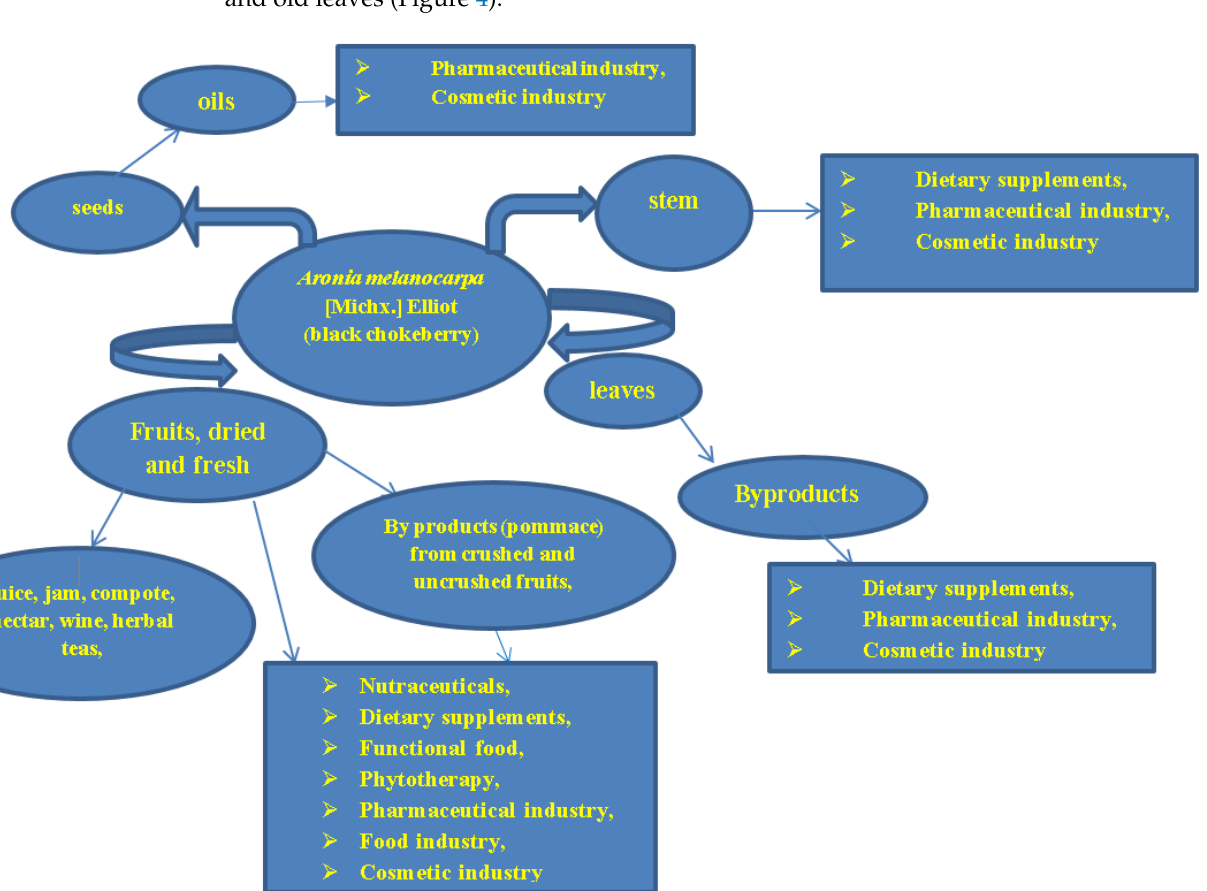
Figure 4. P roposed uses of A. melanocarpa L. and its byproducts. Figure 4. Proposed uses of A. melanocarpa L. and its byproducts. The antioxidant potential of A. melanocarpa leads to diverse antibacterial, antiviral, The extracts obtained from nonedible A. melanocarpa L. leaves have potential use anti-hypertensive, anti-aggregating (anti-coagulant), antilipidemic, anti-diabetic, cardio-, as they have antioxidant, healing, hypoglycemic, antineurodegenerative, and moderate gastro- and hepatoprotective, anti-inflammatory, immunomodulatory and antimicrobial radioprotective activity [97].